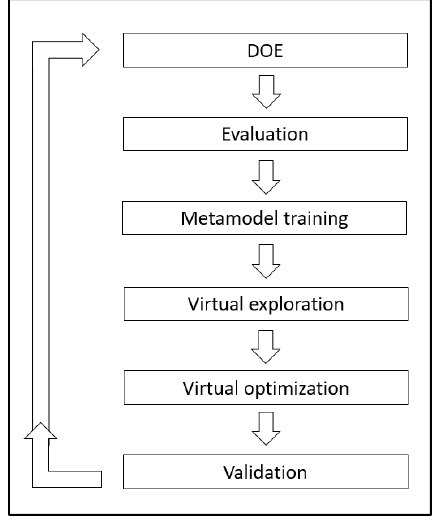
Figure 2. Calculations schematic.